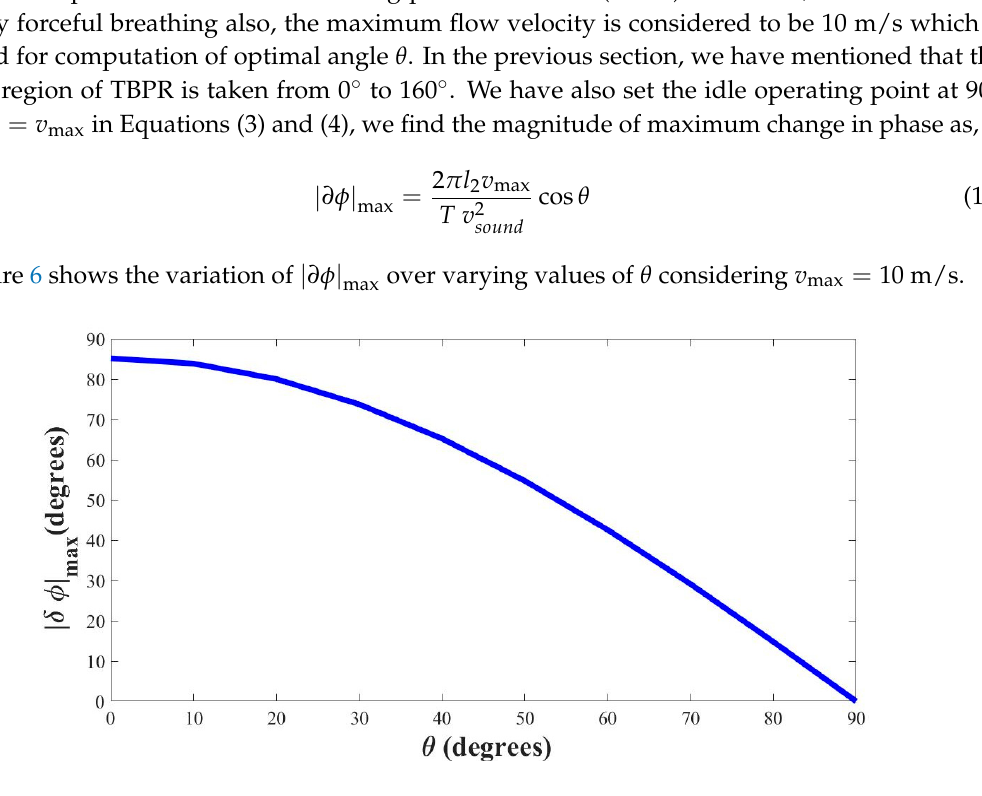
Figure 6. Change in phase ∂φ max with respect to the angle θ ( v max = 10